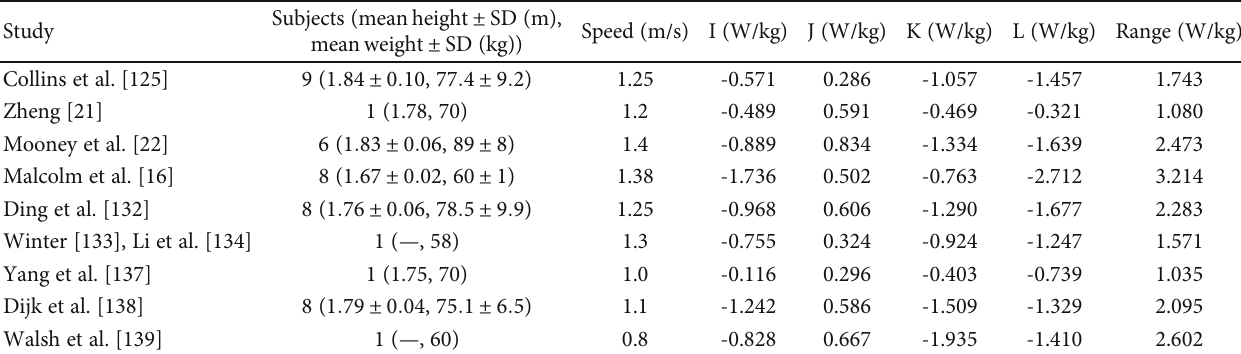
Table 3: Overview over the experimental results of knee power for normal